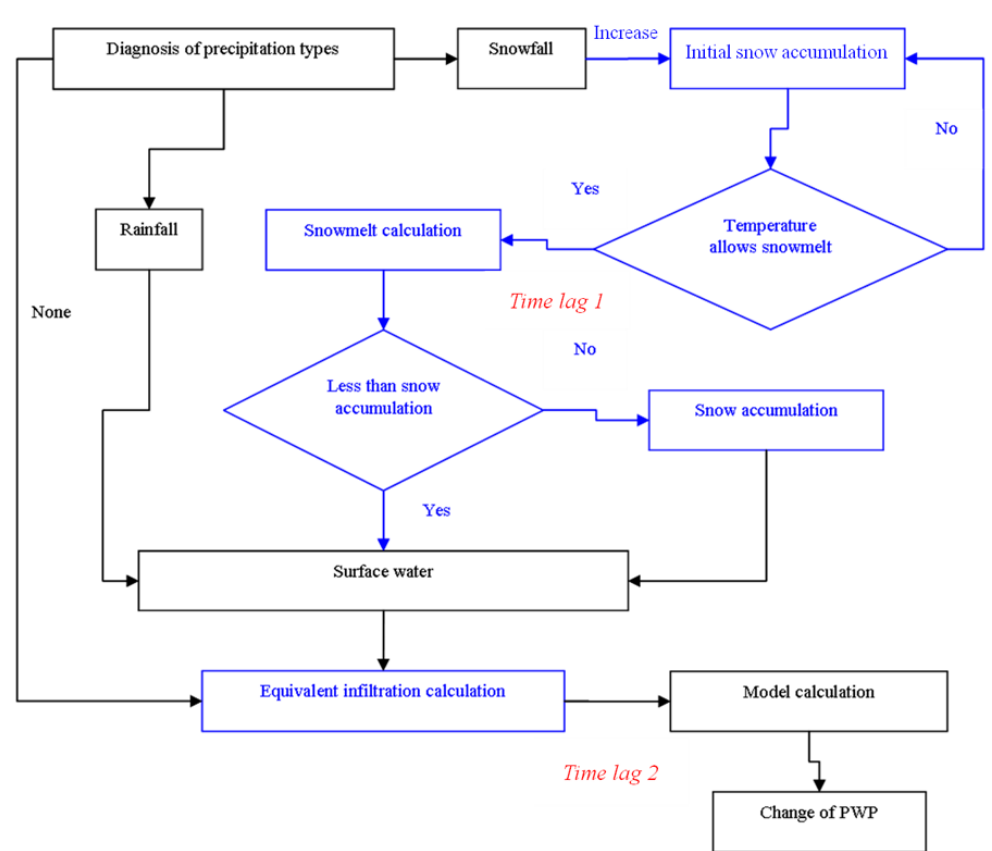
Figure 7. The workflow chart of the modified tank model with respect to the original model. Time lags from snow accumulation, snowmelt and infiltration are highlighted in